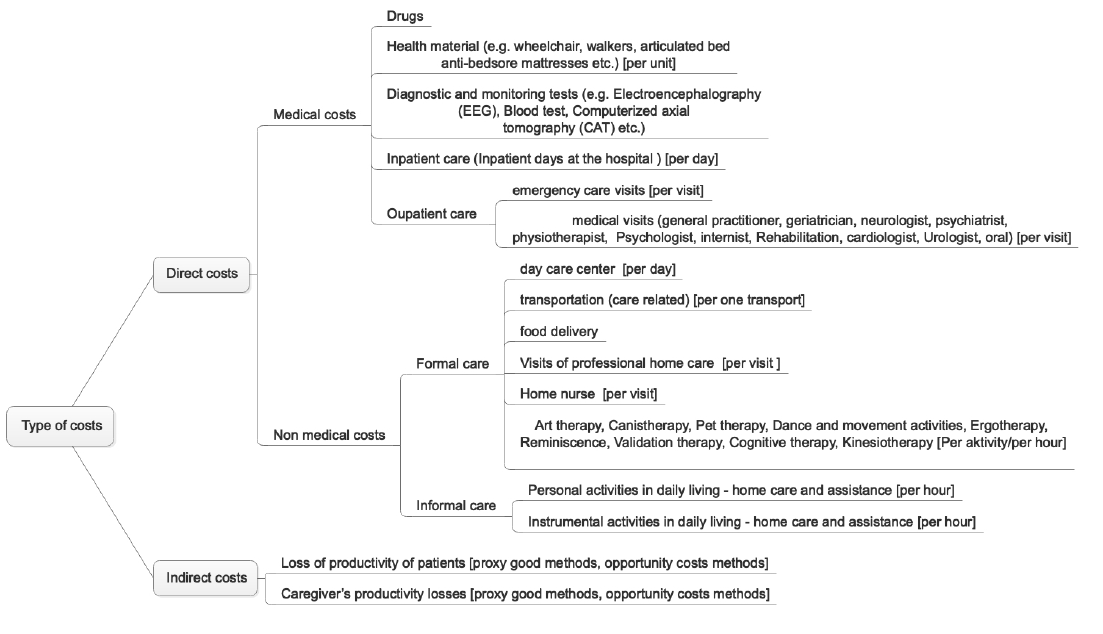
Figure 1. Type of costs (adapted from